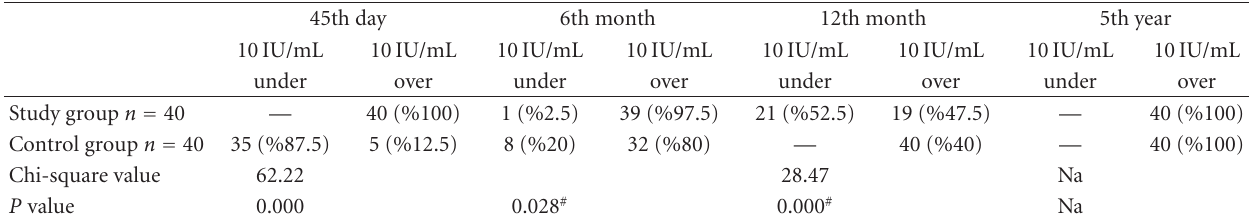
Table 1: Anti-HBs titers after the vaccination scheme in the study group and the control group. 45th day under over under over under over under over